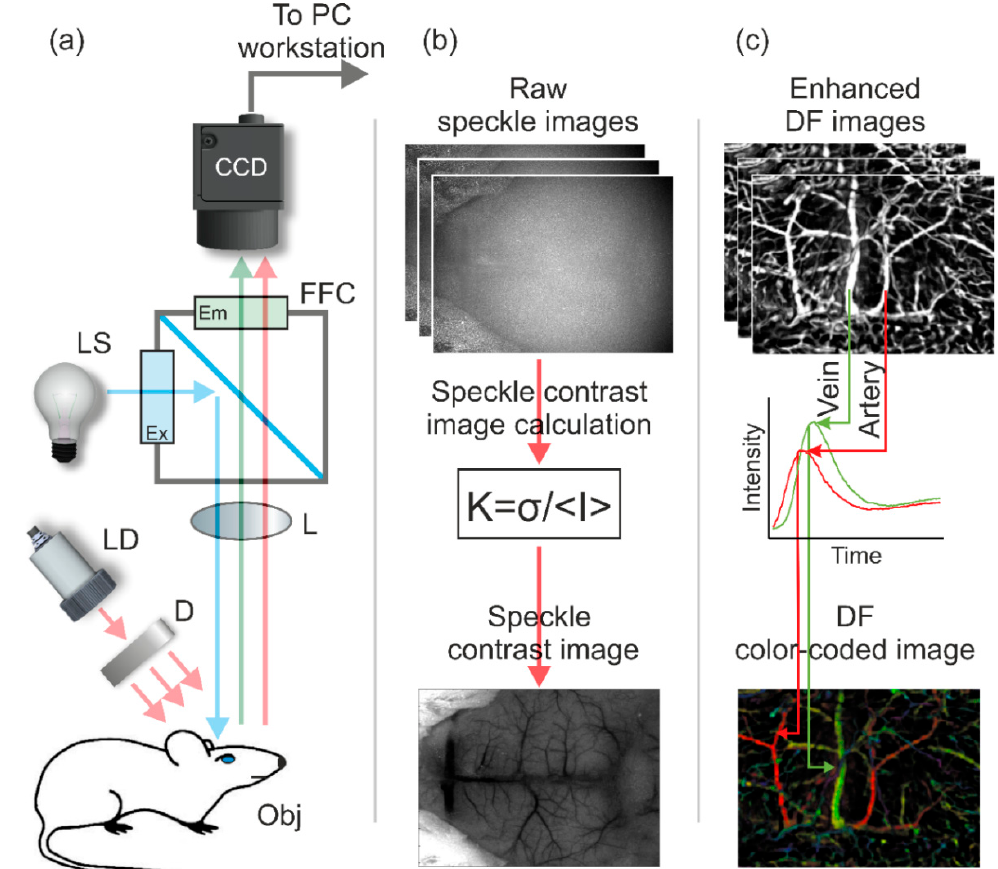
Figure 1. Schematic presentation of principles of operation of the combined laser speckle imaging and fluorescent intravital microscopy (LSI–FIM) experimental system used in the study ( a ): CCD–CCD camera, LS is the light source for fluorescence imaging, Ex is the excitation optical filter, Em is the emission band-pass filter, FFC is the fluorescence filter cube, L are the lens, D is the di ff user, LD is the laser diode for speckle imaging, Obj is the object of investigation. Principle of speckle contrast images calculation ( b ): CCD camera captured stack of raw speckle images. Further, speckle contrast images calculated using Equation (1) by a custom-developed algorithm in o ffl ine regime. ( c ) Principle of color-coded dynamic fluorescent (DF) images obtained with discrimination between di ff erent brain vessels types: CCD camera captured stack of fluorescent images during a 10 s after fluorescent material administration. Further, maximum intensity projection (MIP) has been identified for each pixel in the stack as a function of time. The graph shows florescence intensity as a function of time, illustrating the di ff erence in arrival time between arteries (red) and veins (green). Further, DF color-coded image with discrimination between veins and arteries has been calculated using the intensity-hue-saturation (HIS) color model. Hue encodes time of maximal pixel intensity, whereas MIP is encoded as both intensity and saturation.